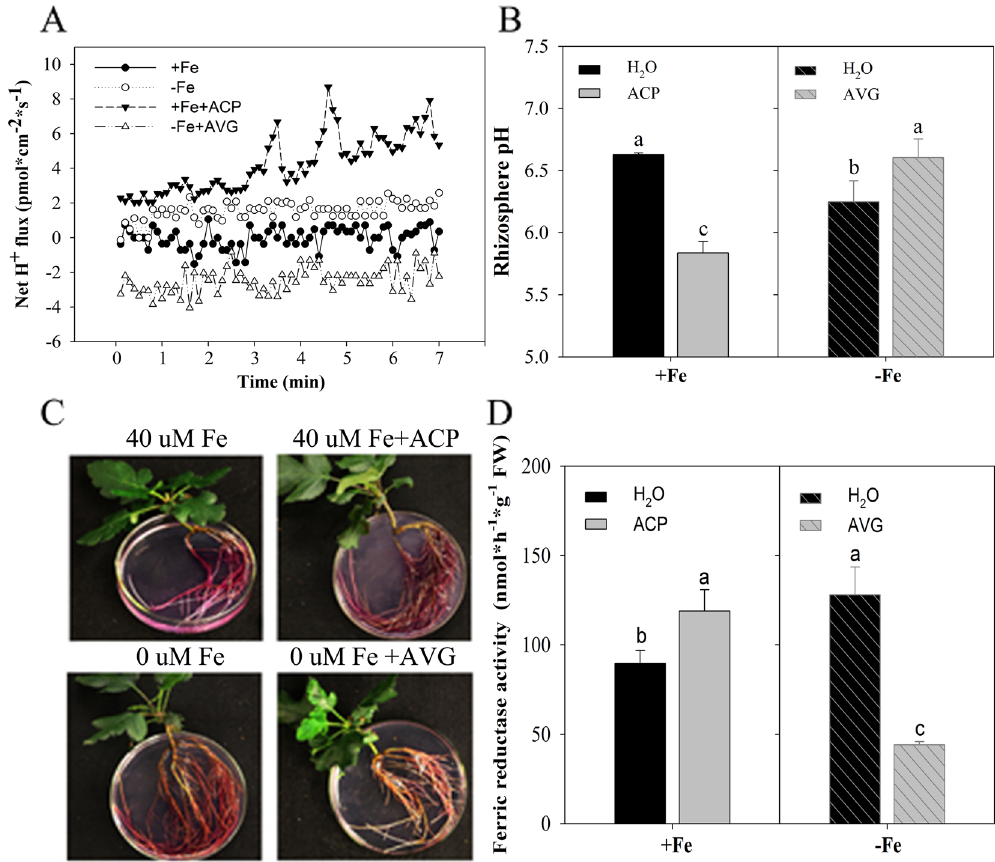
Figure 2. Applying Ethylene treatments effect on Fe-deficient responses in Malus xiaojinensis . (A) Transient H + flux in the plant root hair zone during different treatments (40 µ M Fe, 40 µ M Fe + 100 mg/L ACP, 0 µ M Fe, 0 µ M Fe + 10 µ M AVG for 2 d. (B) Rhizosphere pH of plants grown under different treatments (40 µ M Fe, 40 µ M Fe + 100 mg/L ACP, 0 µ M Fe, 0 uM Fe + 10 µ M AVG) for 2 d. Bars represent means ± SE of three replicates. Different letters represent statistically different means at P < 0.05 (one-way ANOVA analysis with Duncan post-hoc test). (C,D) Rhizosphere ferric reductase activity of plants grown under different treatments (40 µ M Fe, 40 µ M Fe + 100 mg/L ACP, 0 µ M Fe, 0 µ M Fe + 10 µ M AVG) for 2 d. Bars represent means ± SE of three replicates. Different letters represent statistically different means at P < 0.05 (one-way ANOVA analysis with Duncan post-hoc